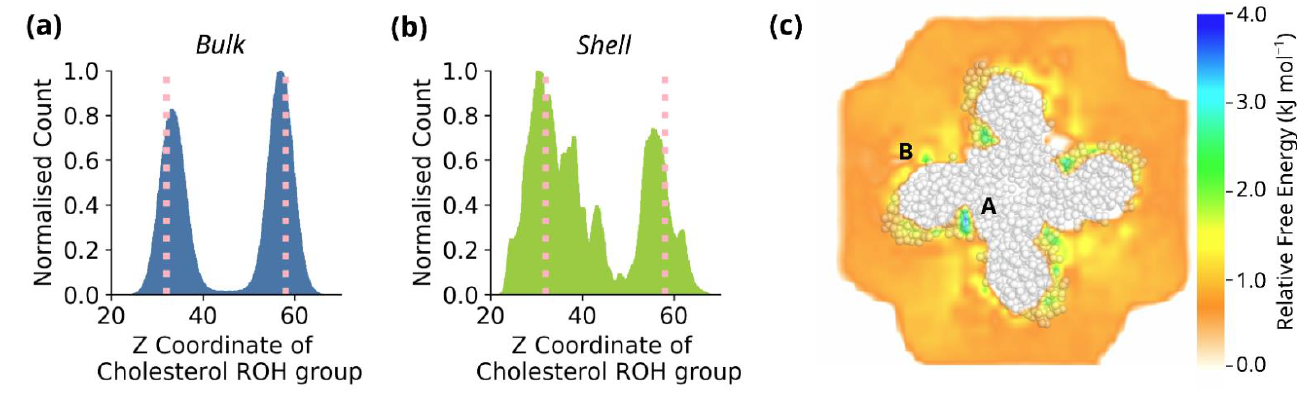
Figure 5. ( a ) The distribution of the ROH group along the Z -axis of the membrane for bulk cholesterol molecules. The pink dots present the Z coordinate of the PC glycerol groups. ( b ) As in ( a ), for cholesterol molecules bound to TRPC3. ( c ) Estimate of the absolute free energy of cholesterol binding to TRPC3, derived using GROmaρs, for a representative simulation. The energy is a relative scale with the minimum defined as 0. TRPC3 is displayed in grey spheres and the absolute free energy is displayed as a colourmap around the protein. The letters A and B refer to regions discussed in the text.